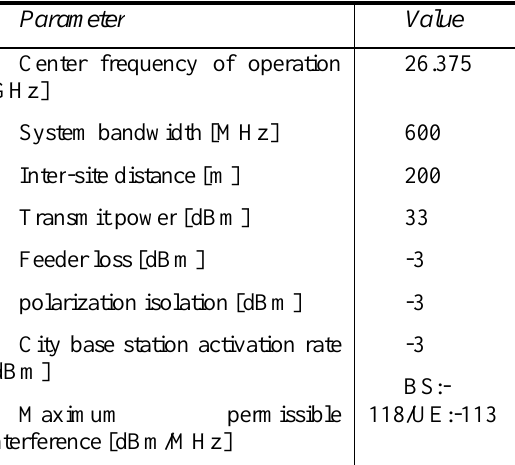
Table 2. IMT-2020 System Parameters